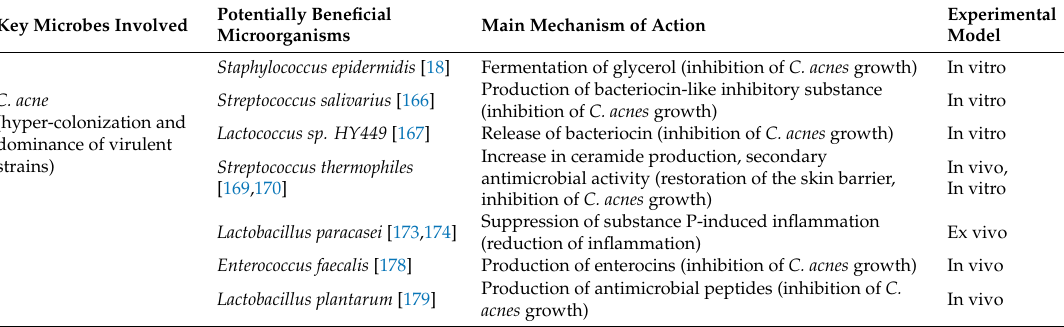
Table 4. Probiotics and